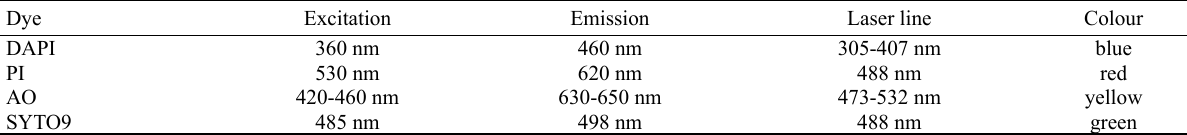
Table S2. – Fluorescence characteristics of the stains used to count and measure marine free-living and biofilm prokaryotes by flow cytometer (Tsuboi et al. 2000, Riccardi and Nicoletti 2006, Pharmingen BD 2020).